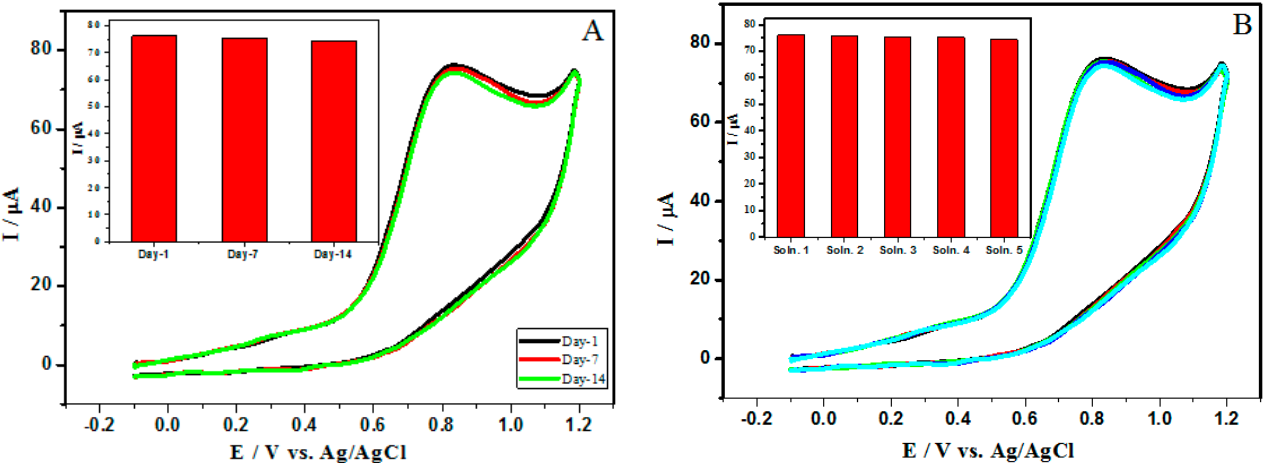
Figure 13. CVs of 3.5 mM of NIC in 0.1 M Na 2 SO 4 (pH 8.0) at the GO/Nq/GCE with a scan rate of 100 mV/s for 14 days ( A ) and five repetitive CVs measurements ( B ).